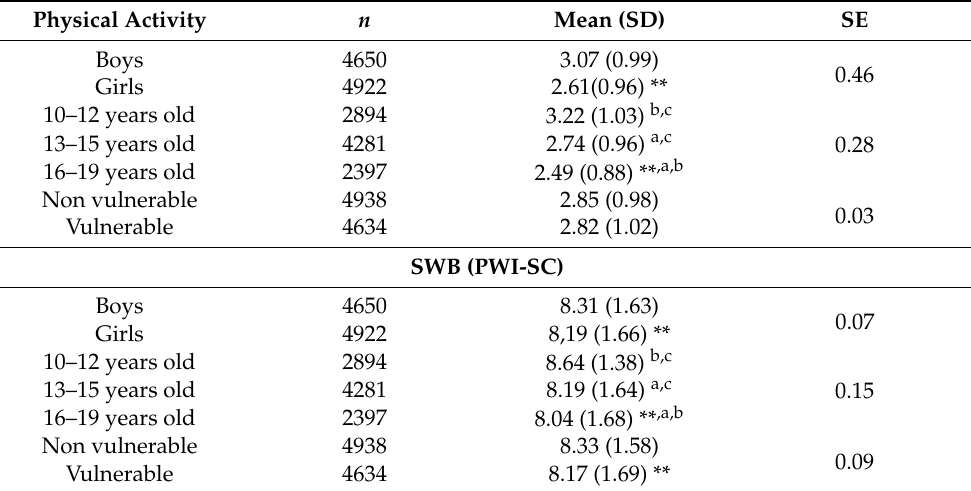
Table 2. Total scores for physical activity habits and subjective